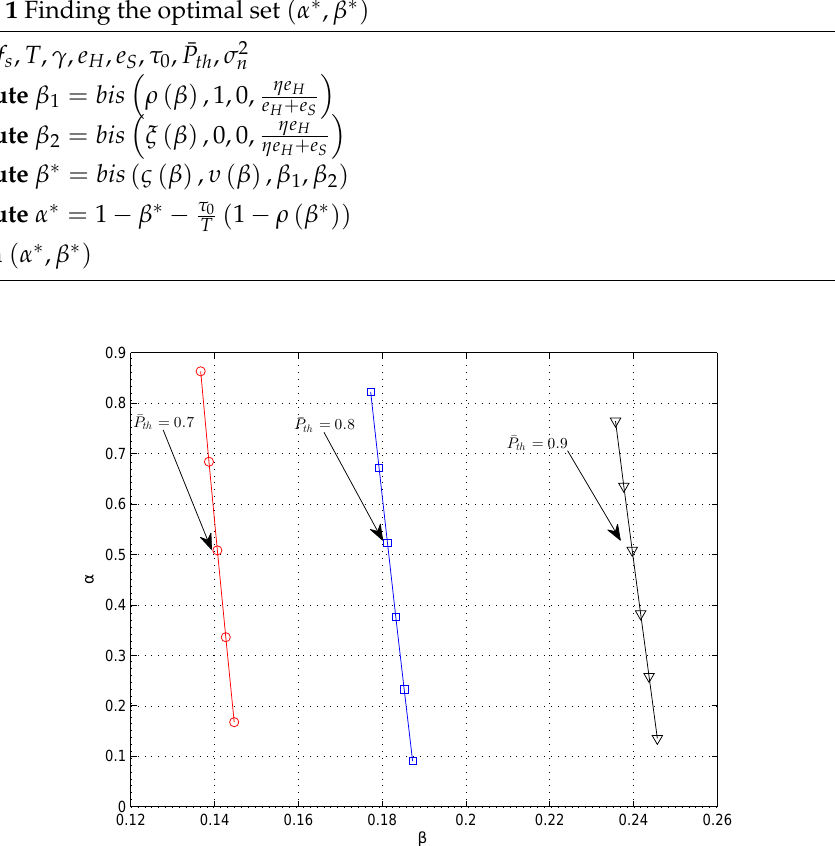
Figure 1. β vs. the corresponding α , for different ¯ P th